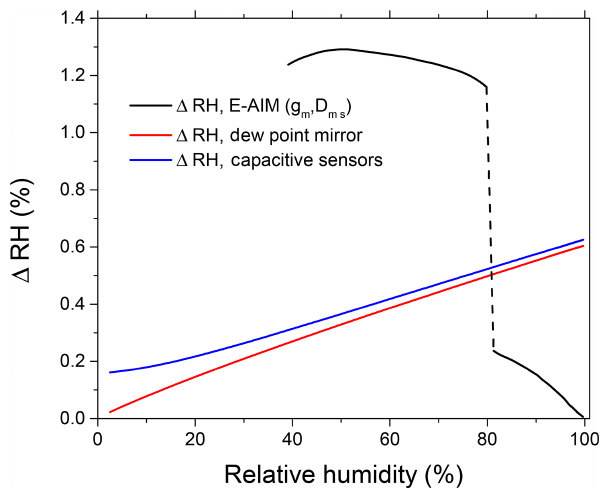
Figure 2. Accuracy in RH using different